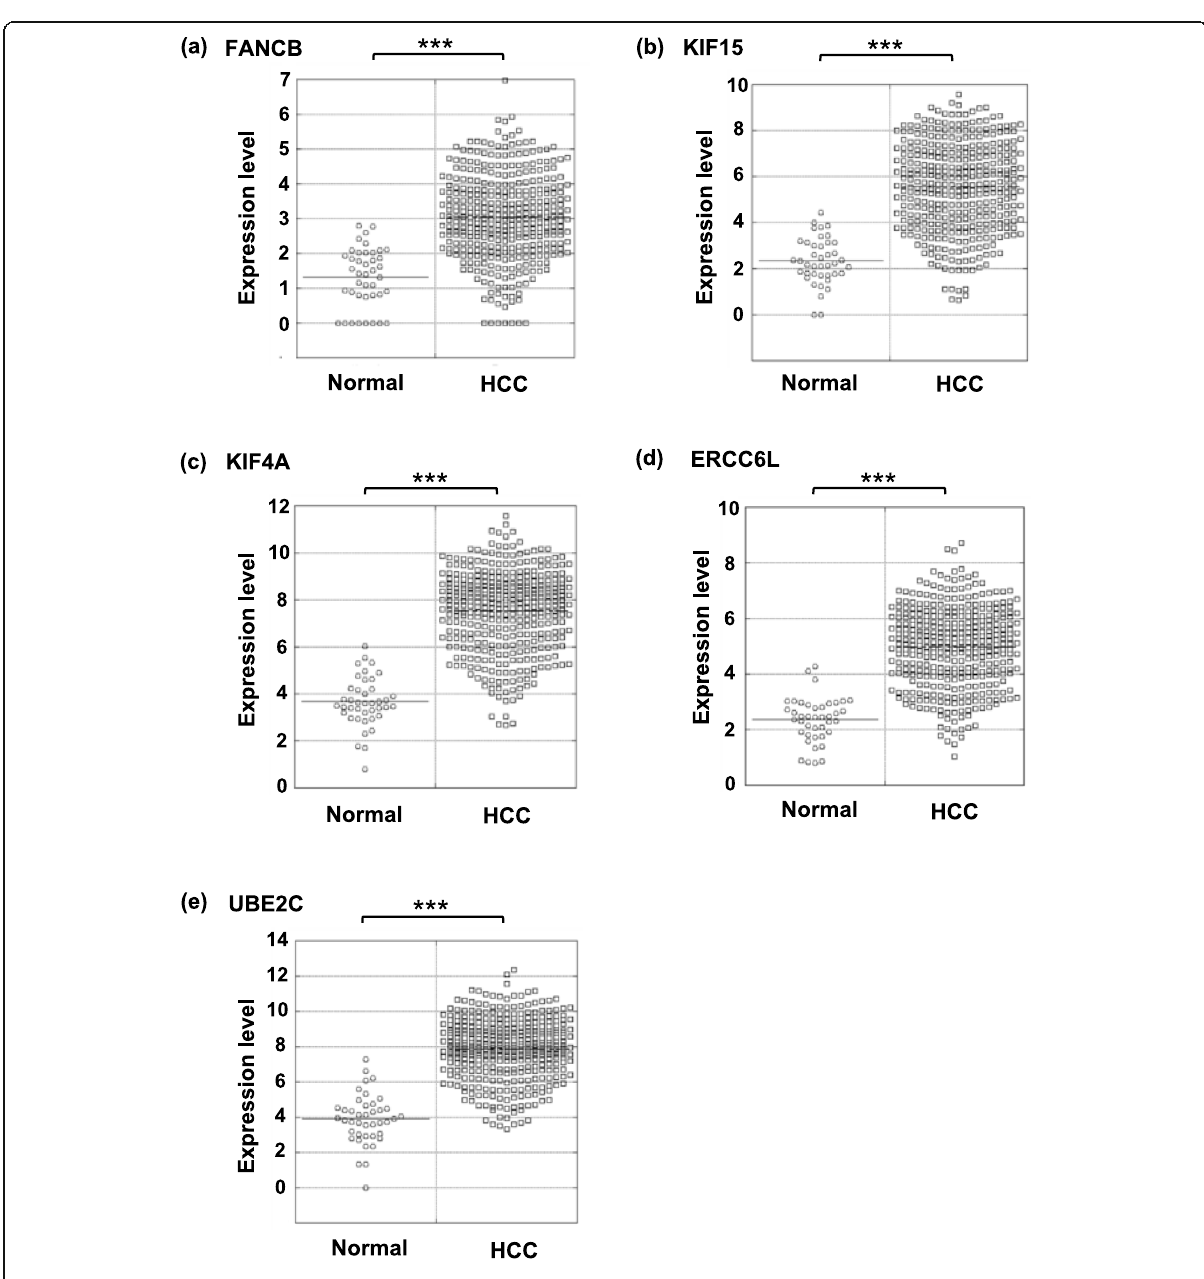
Fig. 4 The expression levels of FANCB ( a ), KIF15 ( b ), KIF4A ( c ), ERCC6L ( d ), and UBE2C ( f ). Statistical significance between the two groups was analyzed by Student ’ s t test. *** Significantly different at p <